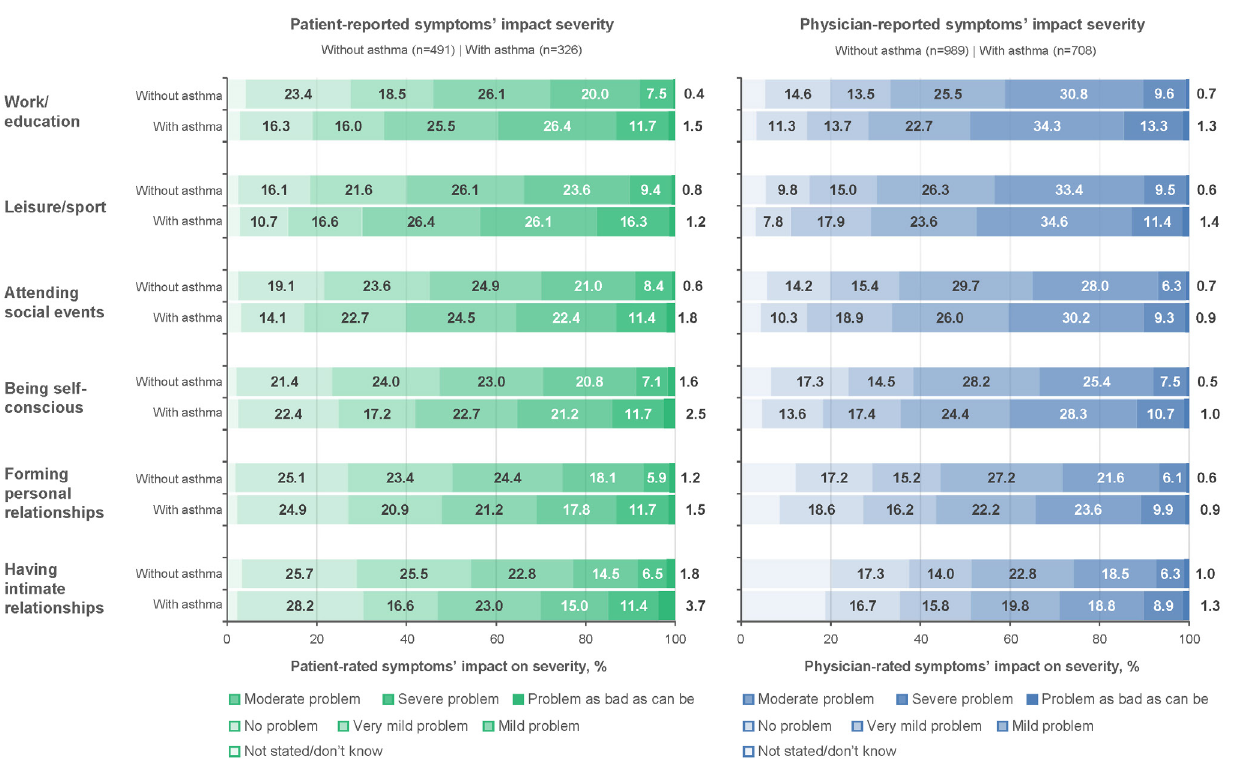
Supplemental Figure 4. Extent of CRSwNP symptoms’ impact on daily activities and relationships by categories of asthma comorbidity (total sample with known asthma status). a CRSwNP severity determined by physician for each patient based on physician’s clinical expertise and provided guidance to follow the European Position Paper on Rhinosinusitis and Nasal Polyps guidelines (2,10) and NP size scoring systems. Abbreviations: CRSwNP, chronic rhinosinusitis with nasal polyposis; NP, nasal